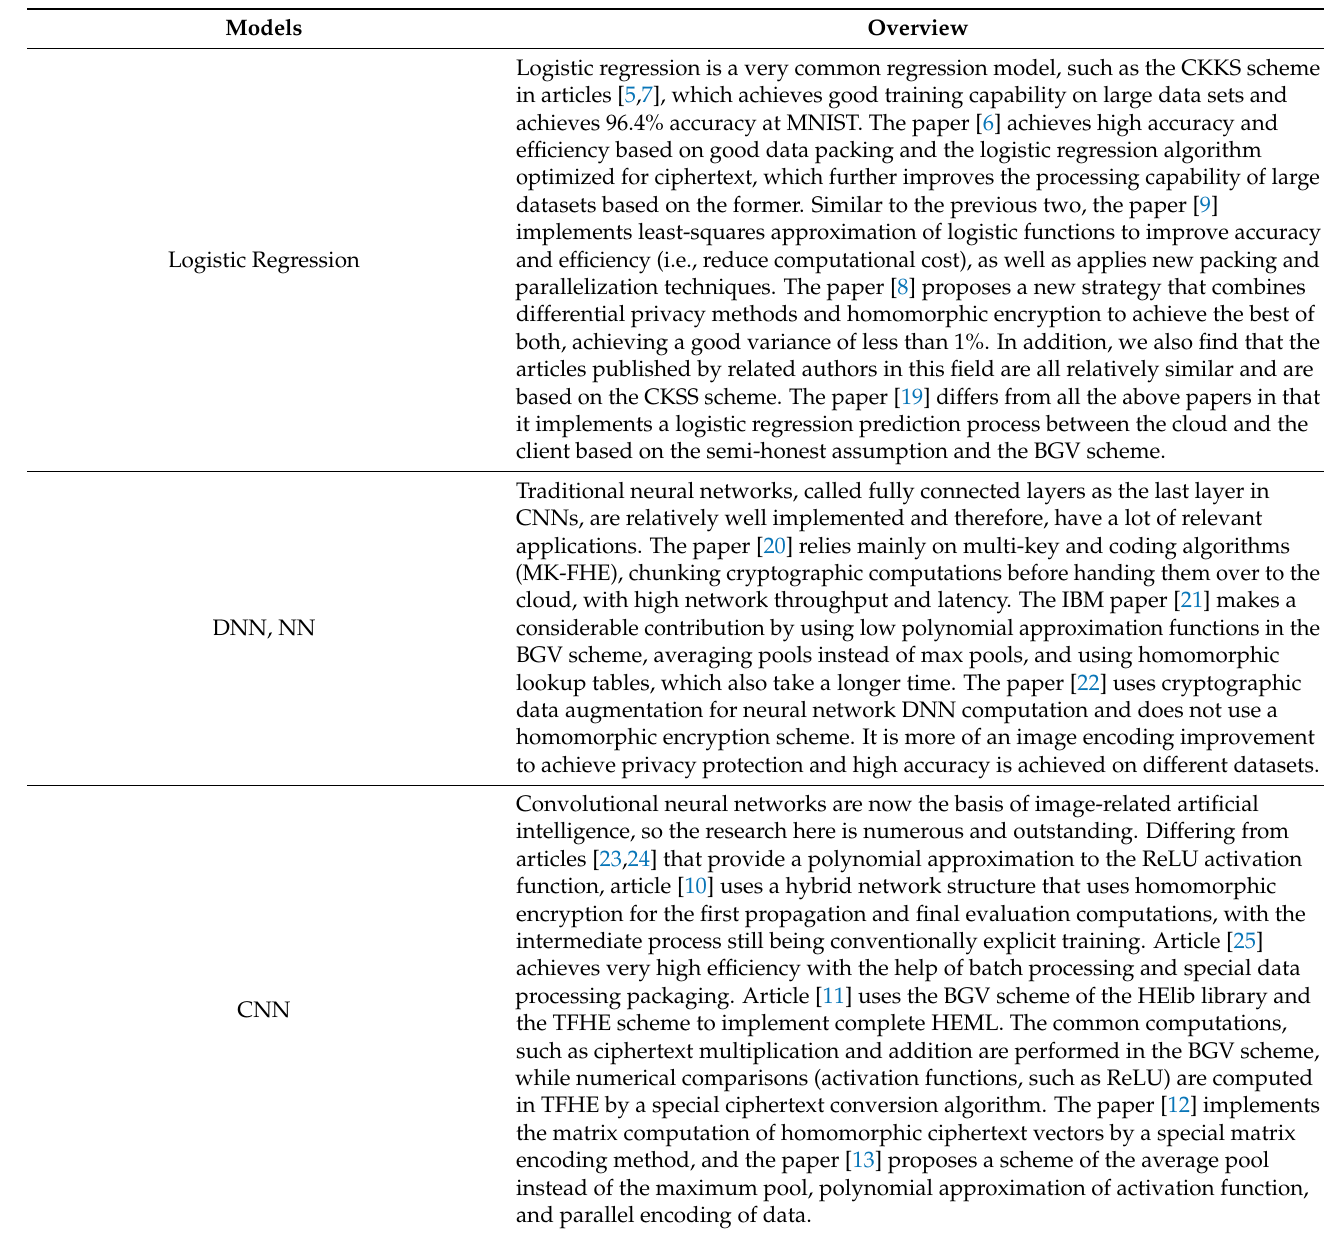
Table 1. An overview of some related